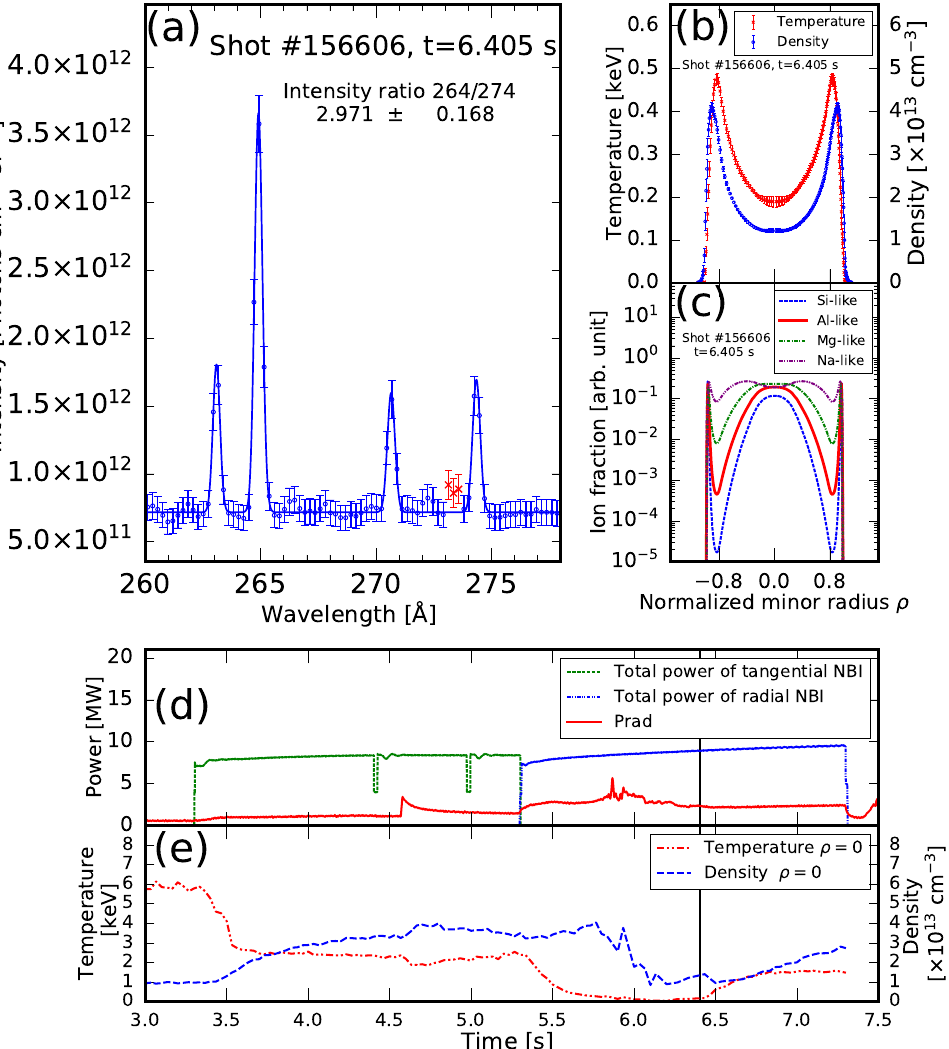
Figure 10. Summary of plasma condition in LHD for Fe XIV emission lines measured when hollow electron temperature distribution is produced with low temperature at central plasma (discharge #156602). Time of ( a )–( c ) is at t = 6.405 s. ( a )–( e ) is same as in Figure